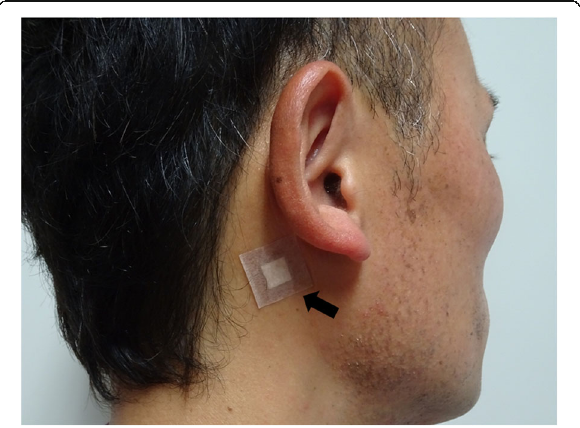
Fig. 2 Position in which the scopolamine patch was attached. A small amount of scopolamine ointment was applied near the papillary process in the posterior